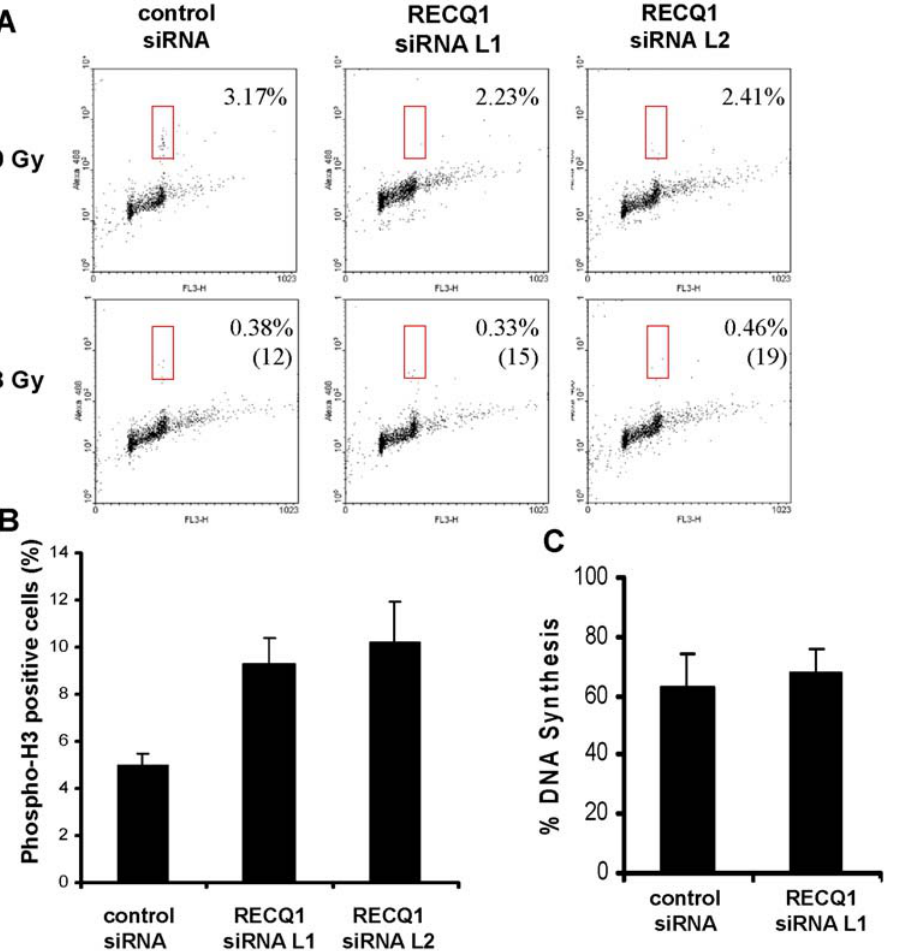
Figure 7. Effect of RECQ1 depletion on G2/M and intra-S-phase DNA damage checkpoints. Panel A , DNA damage-induced mitotic entry delay is minimally affected by the RECQ1 deficiency. HeLa cells were transfected with the indicated siRNAs and either mock-treated or exposed to 3 Gy of IR 1 h before harvesting. Mitotic cells were detected by PI and phosphohistone H3 staining and analyzed by flow cytometry. Percentages of mitotic cells and their levels normalized to control (in parentheses) are shown. Panel B, RECQ1 is involved in maintenance of IR-induced G2/M checkpoint. Cells with either control or RECQ1 siRNA were exposed to 10 Gy of IR. Nocodazole (1 m g/ml) was added to the medium at the time of IR treatment to capture cells entering mitosis. 16 h later, cells were collected for PI and phospho-histone H3 staining and analyzed by flow cytometry. Panel C, HeLa cells transfected with control or RECQ1 siRNAs were exposed to 10 Gy of IR and assayed for DNA synthesis 30 min later by [ 3 H]thymidine incorporation. The amount of DNA synthesis after irradiation is expressed as a percentage of the level in untreated cells. Error bars indicate SD from three independent experiments.